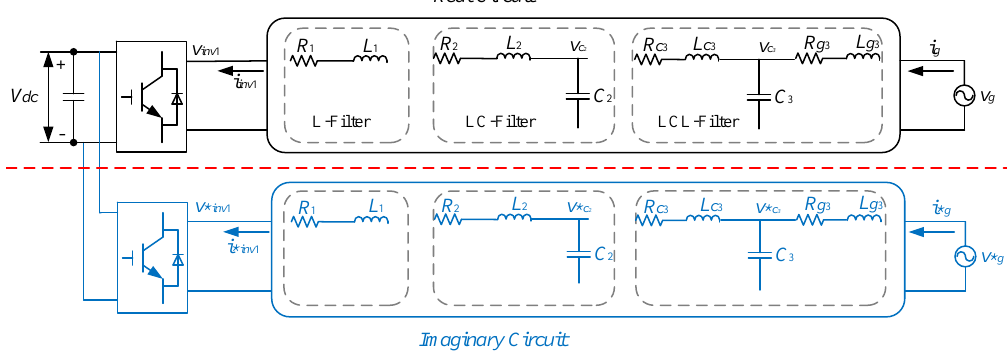
Figure 1. The schematic of a single-phase grid-connected converter (GCC): real circuit and imaginary